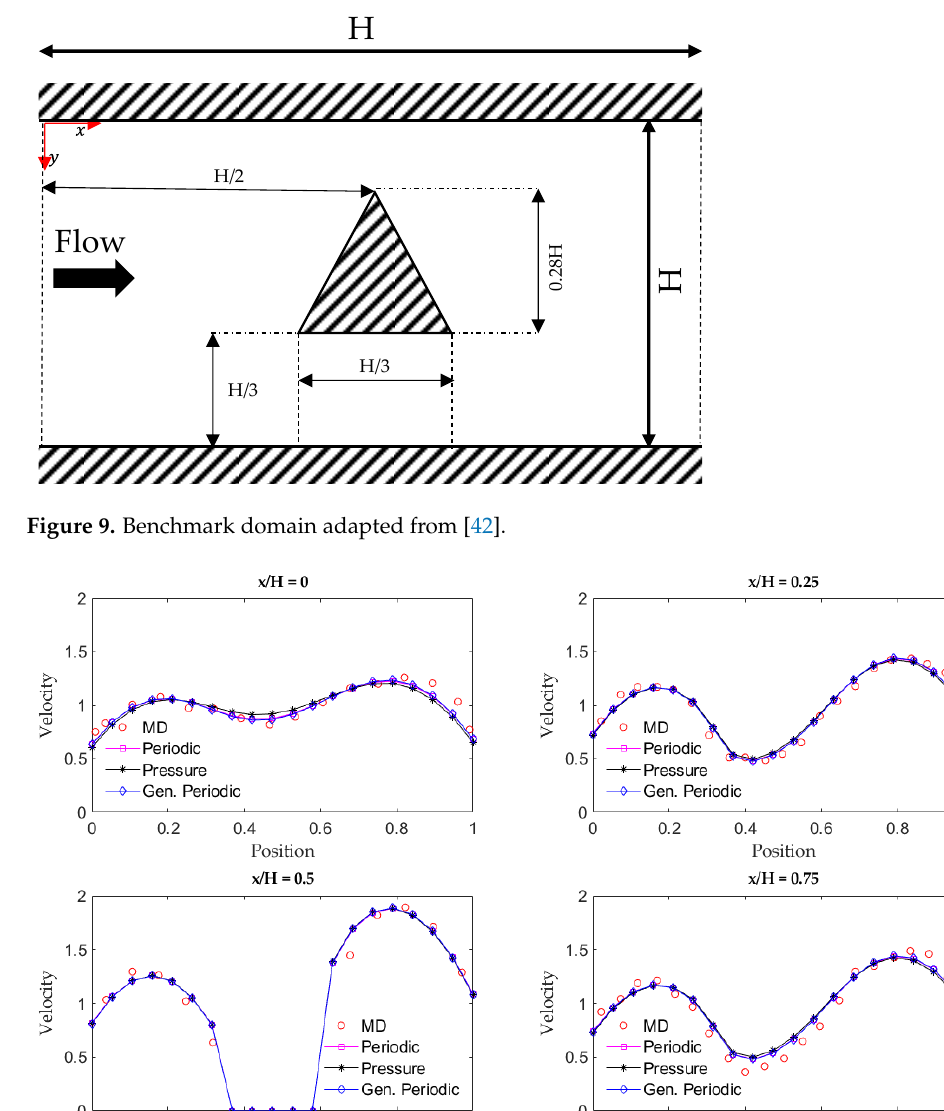
12 of 21 Figure 8. Velocity profiles using three inlet–outlet treatments at different cross sections. Y axes rep- resent normalized streamwise velocity, and X axes represents the position across the channel. The domain shown in Figure 9 is adapted from [43]. The domain comprises a simple channel with a triangular obstacle with a stair-wise boundary. We simulate flow in this